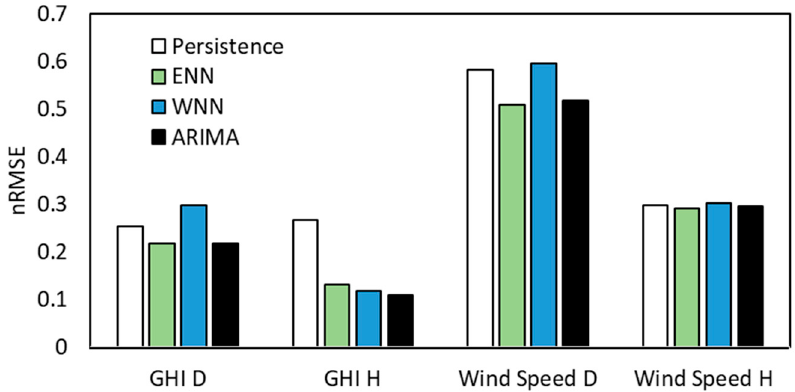
Figure 5. The nRMSE of Different Forecast Methods.